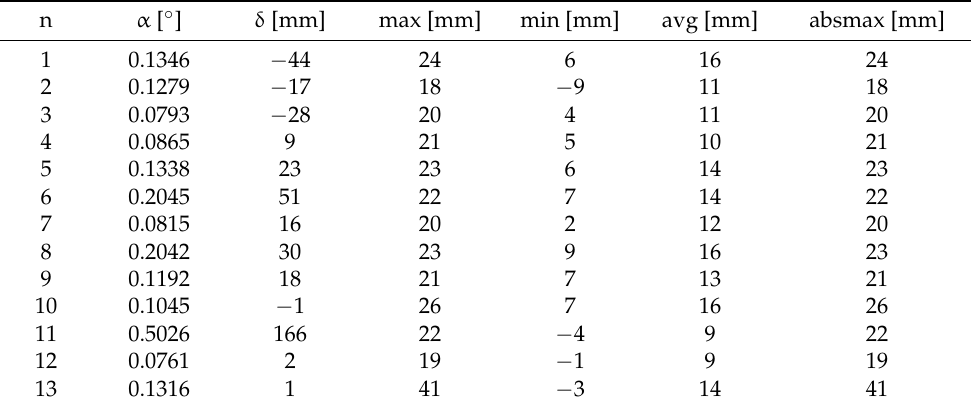
Table 2. Deviations between the BIM model and the as-built model.